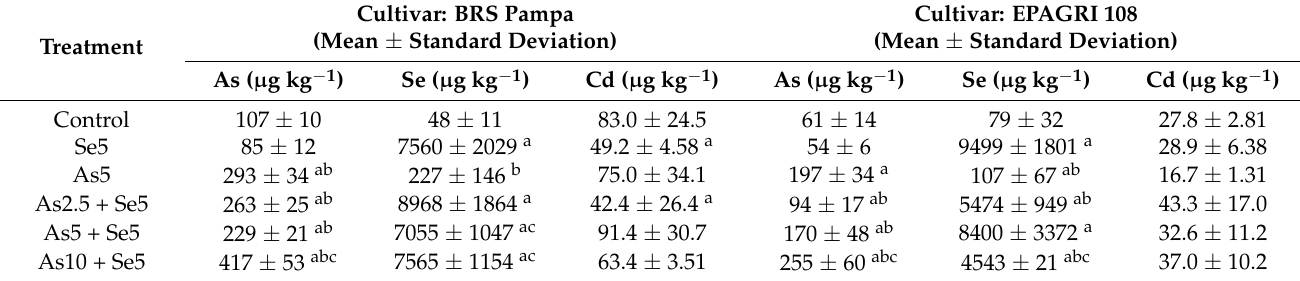
Table 2. Concentration of As, Se, and Cd in grains of the cultivars BRS Pampa and EPAGRI 108 in all treatments. Results expressed as mean ± standard deviation (n = 5); a,b,c : significative statistical differences at p <